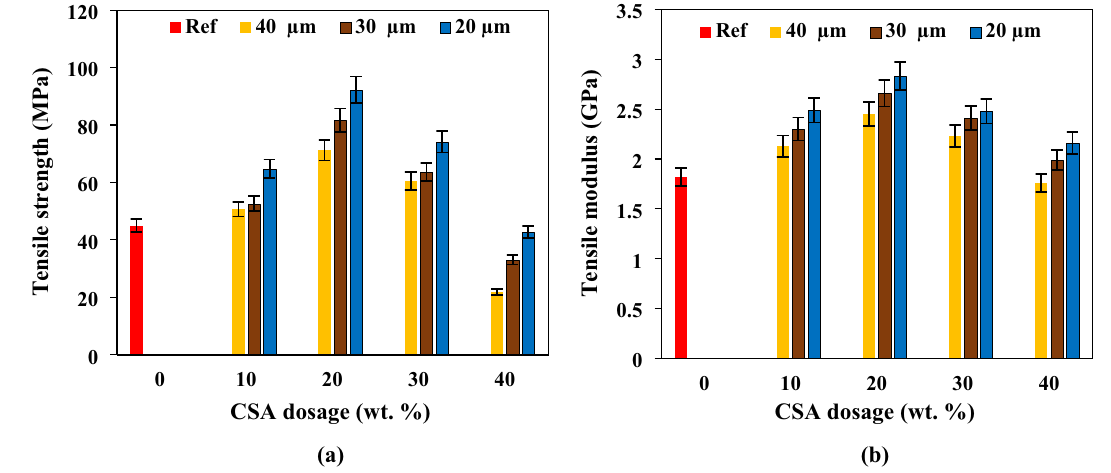
Figure 2. Influence of CSA proportion and size on ( a ) tensile strength ( b ) tensile